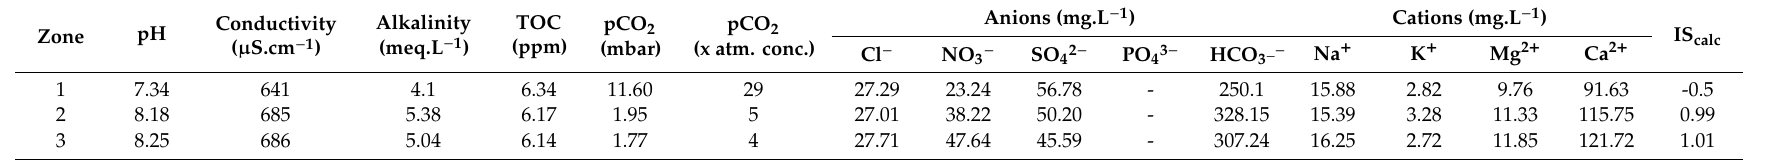
Table 2. Average of main physicochemical parameters according to the zones (see Table S1 for